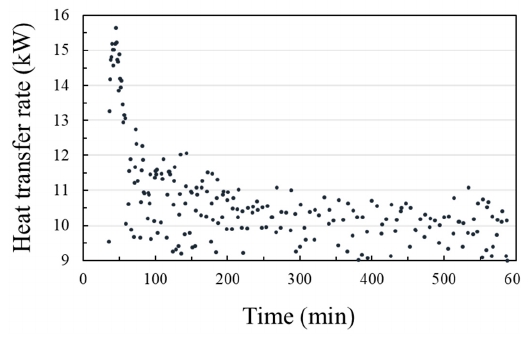
Figure 4. Heat transfer rate—HDPE.